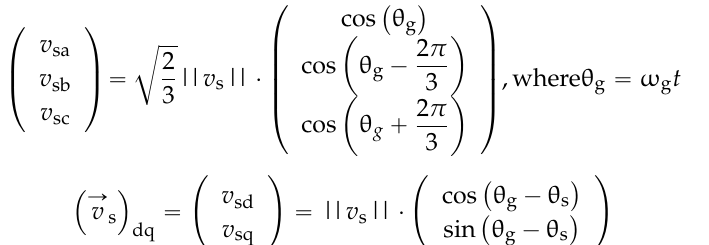
Table 3. Parameters of the RSC’s control system.